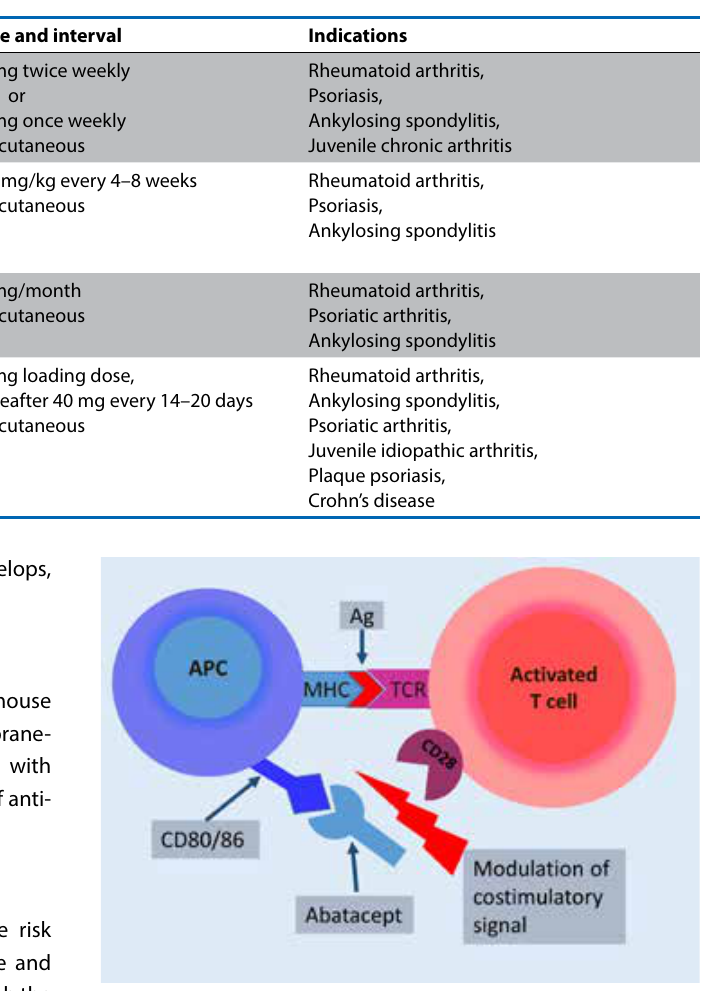
Figure 3. A schematic diagram showing the binding of abatacept to CD80/86 and preventing its interaction with CD28 on naïve T-cells. APC: antigen presenting cell; MHC: major histocompatibility complex, TCR: T-cell receptor, Ag: antigen, CD28: receptor molecule for